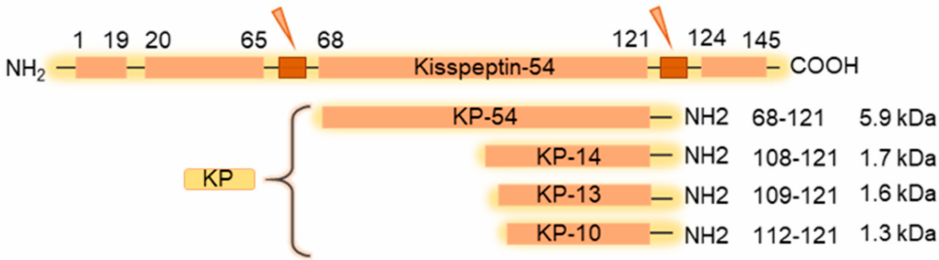
Figure 1. Expression and processing of pre-pro-kisspeptin. Kisspeptins (KPs) are encoded as a common precursor. The pre-pro-kisspeptin is a 145 amino acid peptide, with a 19-amino acid signal peptide and a main 54-amino acid region (52 amino acid in in rodents), kisspeptin-54/52 (KP-54/52). KP-54/52 is further processed into peptides of lower molecular weight: KP-14, KP13, and KP-10. All KPs contain the RF-amide (in primates) or RG-amide (in rodents) motif in the C-terminus that can bind and activate the KP